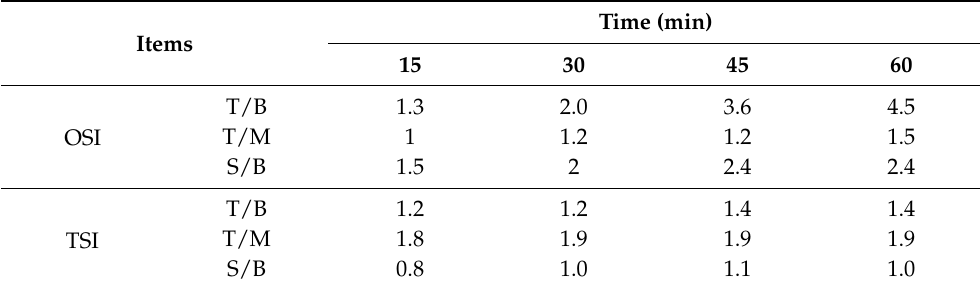
Figure 2. Boron concentrations were presented in ( A ) blood, ( B ) tumor, ( C ) muscle, and ( D ) skin. The predicted boron concentration in blood was analyzed by curve fitting and expressed as mean ± standard deviation. *: p ≤ 0.05, **: p ≤ 0.01, and ***: p ≤ 0.001 statistically significant difference, evaluated using paired t-test. Table 1. Difference in boron ratios between one-step infusion (OSI) and two-step infusion (TSI) at sampling time points after the first step infusion.